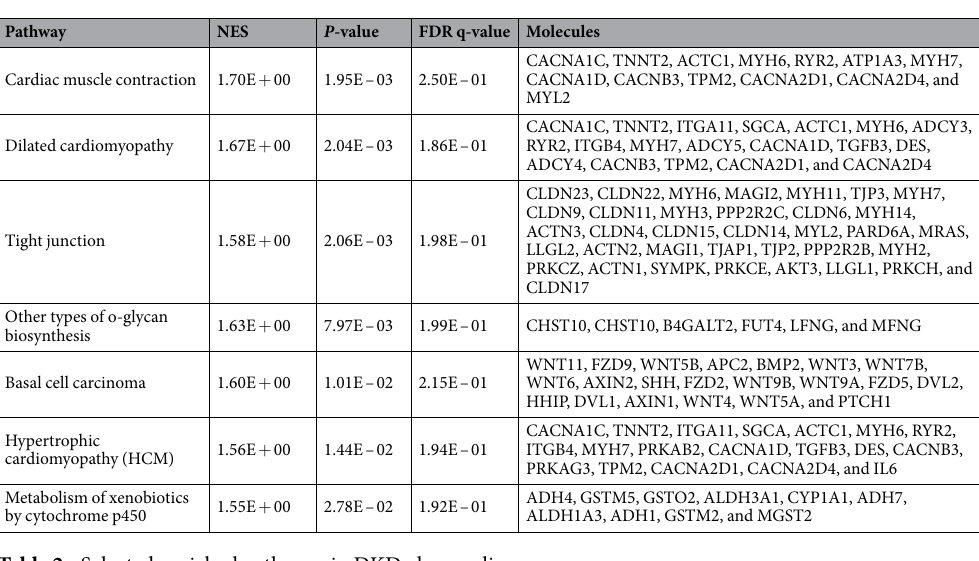
Table 2. Selected enriched pathways in DKD